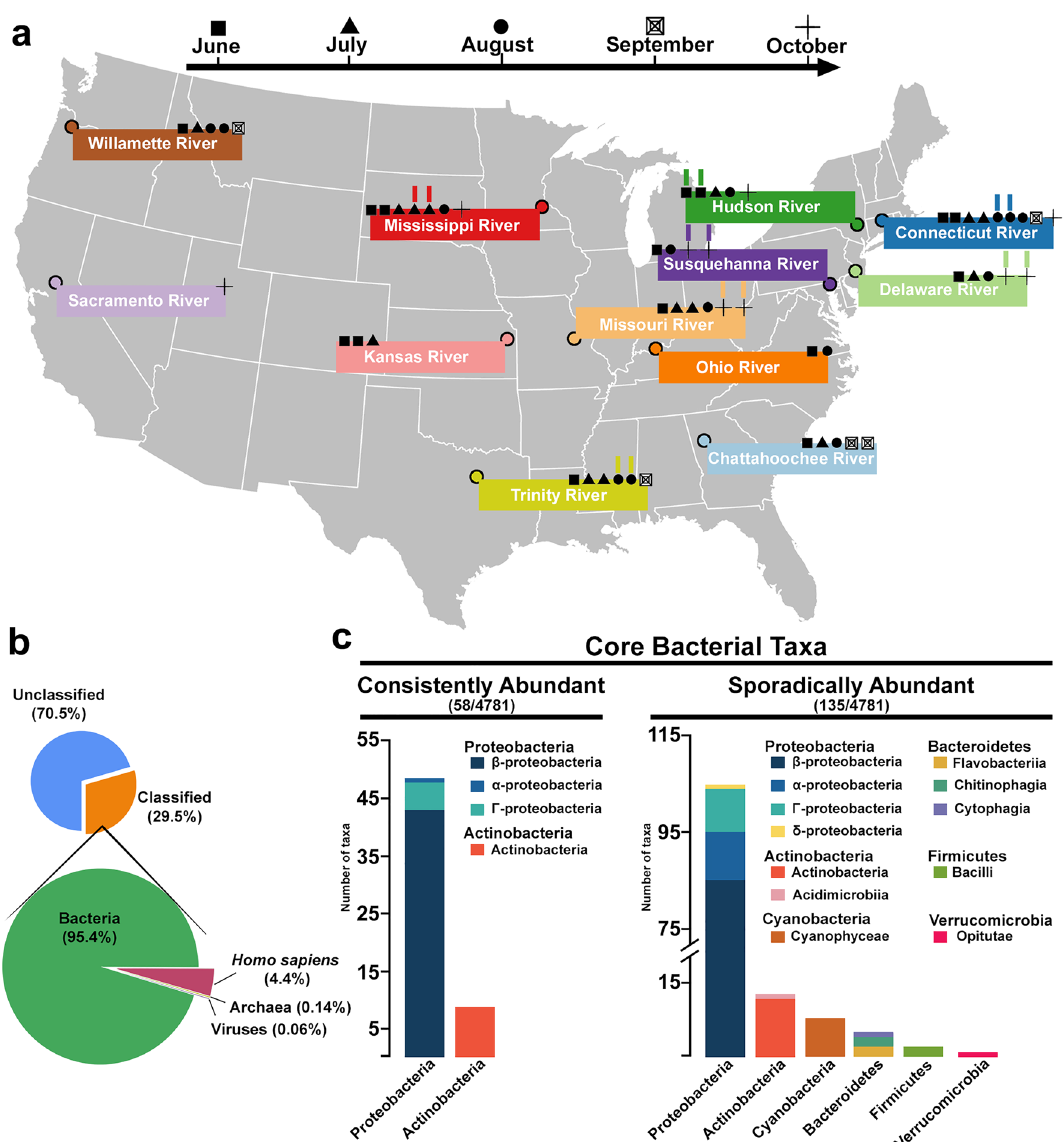
Figure 1. U.S. river samples and ‘core’ microbial communities. ( a ) River location and month of sampling (in 2019). Samples taken sequentially (replicates) are indicated by colored hashes above date shape. ( b ) Pie charts depicting reads that were unclassified (blue) vs classified (orange) (top pie chart) and their broad taxonomic distribution (bottom pie chart). ( c ) The taxonomic composition of the most abundant (core) river taxa at the phylum and class level. The left graph depicts taxa that were consistently highly abundant (> 0.1% relative abundance) across a majority of river samples (> 80%), while the right graph shows taxa that were highly abundant, but not consistently: taxa that were sporadically